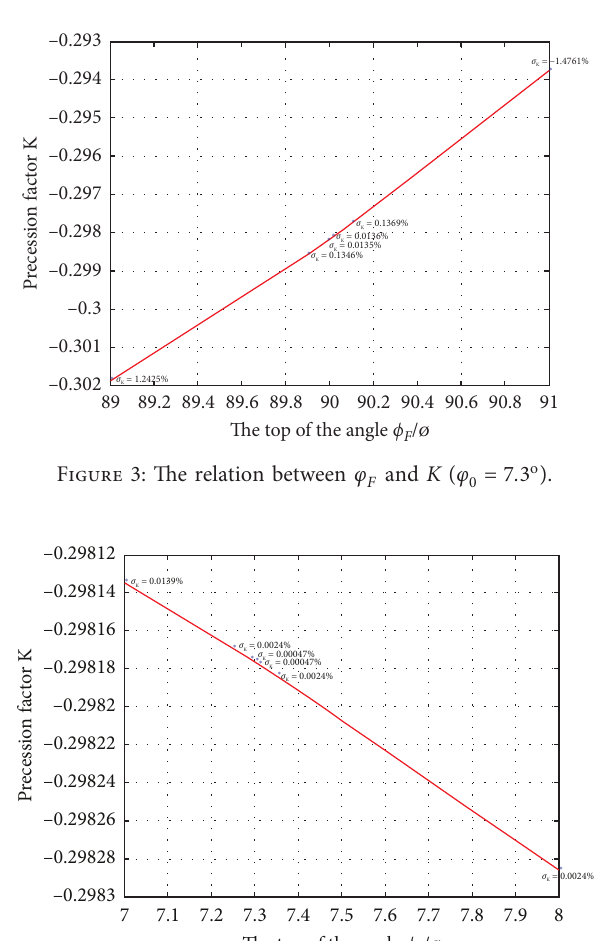
Figure 4: The relation between φ